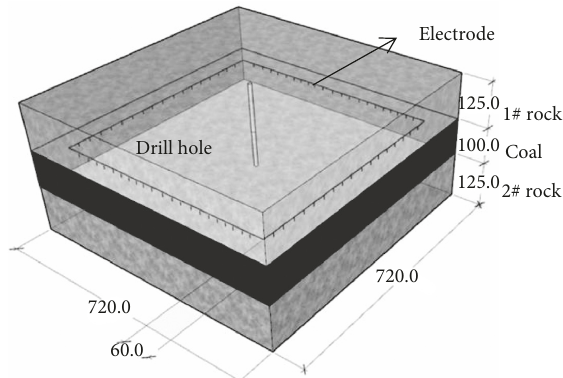
Figure 2: Electrode position distribution (unit: mm).